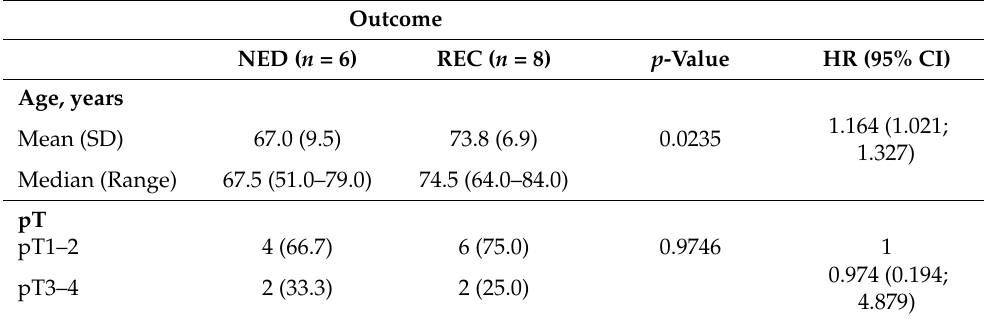
Table 3. Descriptive statistics and univariate Cox’s regression results on demographic and clinical- pathological variables within the BSCC group.